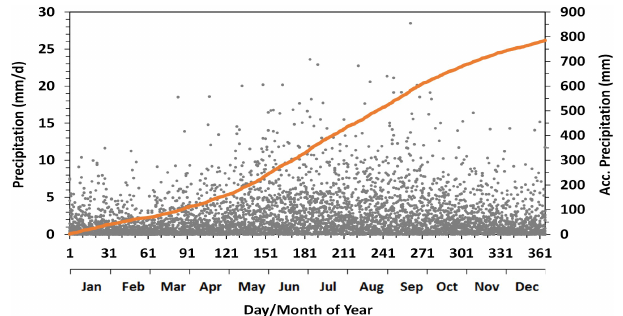
Figure 3. Daily precipitation for the Albany River watershed over the study period (2002–2016). Orange line represents the accumu- lated precipitation in a year using the 15-year mean daily values.